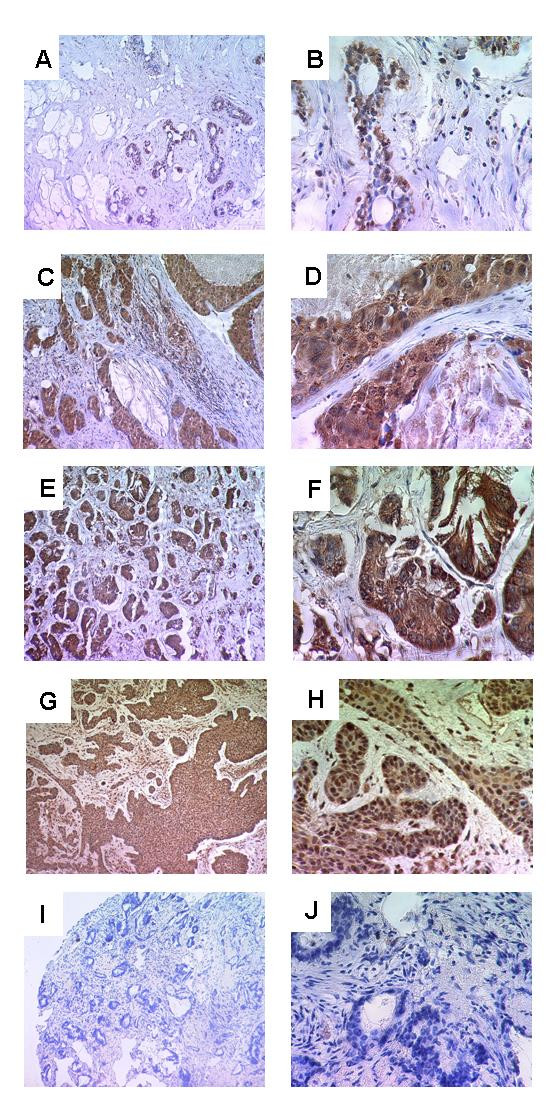
Immunohistochemical expression analysis of GLI1 protein in normal breast tissue, non-invasive and invasive breast tumours using a TMA. (A, B) In normal breast tissue low levels of GLI1 expression are detectable in the cytoplasm (median IRS = 4) and in the nucleus (median IRS = 6). In ductal carcinomas in situ of high grade type (C, D) as well as in invasive breast carcinomas (E, F) nuclear GLI1 expression is more intense than in normal breast tissues (median IRS = 8), whereas the cytoplasmic GLI1 expression is weak (median IRS = 3). (G, H) Representative tissue section from human basal cell carcinoma which served as a positive control for GLI1 staining. (I, J) Negative control – benign breast tissue. Magnifications: A, C, E, G, I: 100×; B, D, F, H, J: 400×.